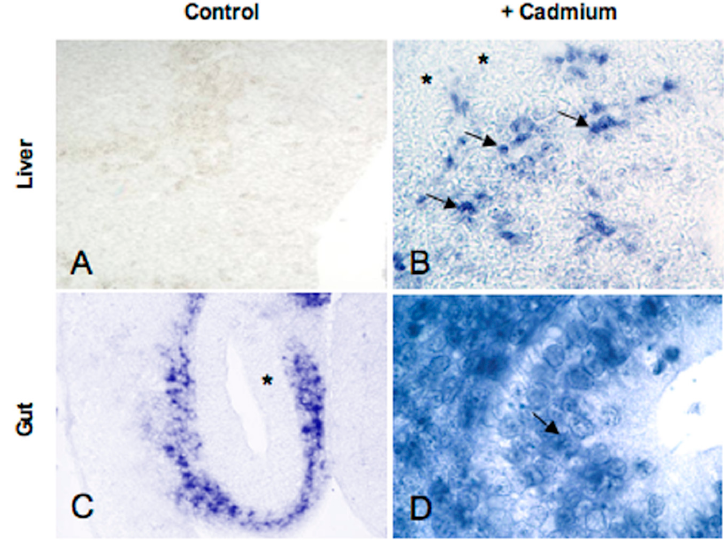
Figure 6. Cd-induction of MT expression in the liver and gut of a P. sicula embryo. Photographs are modified from [58]. ( A , C ) Control embryo at 10 days pd. ( A ) Unlabeled liver parenchyma; ( C ) gut mucosa completely unlabeled (*). ( B , D ) Cd-treated embryo at 10 days pd. ( B ) Several sinusoidal cells (arrows) are labeled, liver parenchyma () is unlabeled; ( D ) gut mucosal cells show intensely labeled nuclei (arrow). Objectives: ( A , B ): 20 × ; ( C ): 10 × ; ( D ): 40 ×